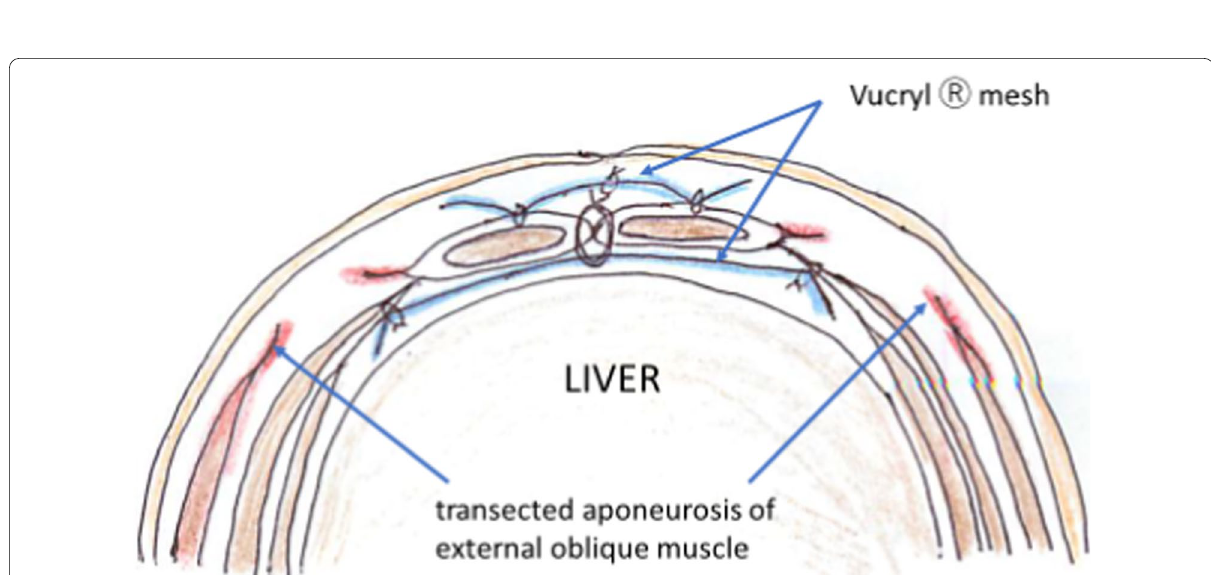
Fig. 5 A schema of the abdominal wall after the procedure. Underlay Vicryl Ⓡ mesh was fixed to the transversalis fascia and onlay mesh was fixed to the rectus abdominis